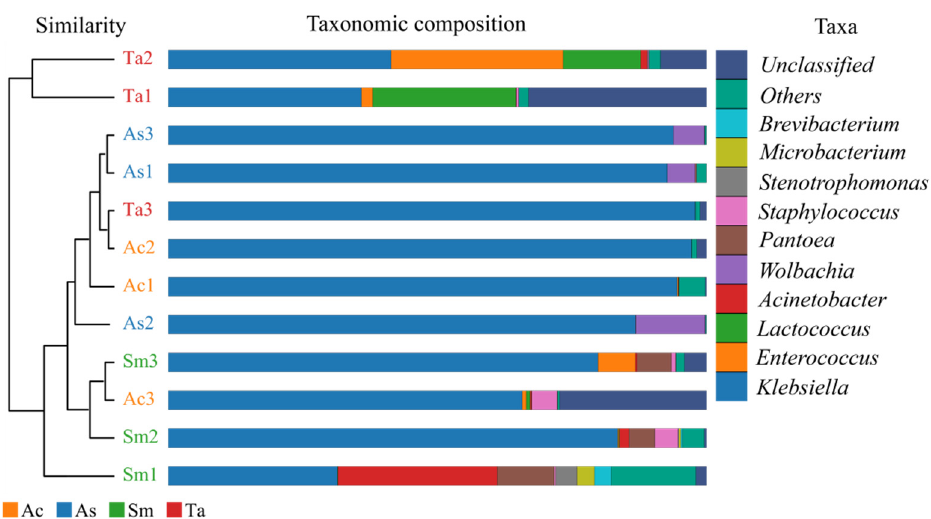
Figure 4. UPGMA cluster tree combined with histogram. The clustering tree and the abundance histogram are shown on the left and on the right, respectively. The top 10 genera in relative abundance were shown here. “Others” represented the remaining. “Unclassified” represented OTUs that were not commented. Ac, Acridia chinensis ; As, Atractomorpha sinensis ; Sm, Sphingonotus mongolicus ; Ta, Trilophidia annulate .